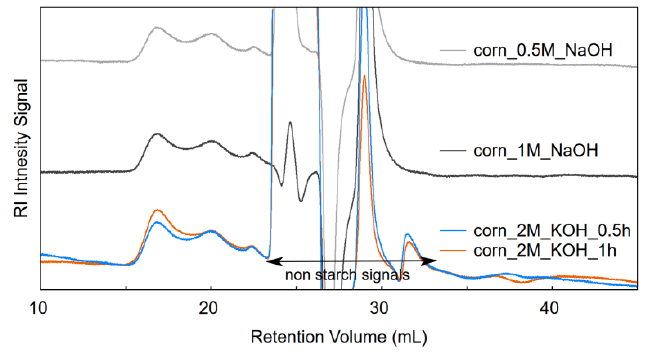
Figure 4. SEC chromatograms of corn starch samples dispersed in aqueous solution NaOH or KOH at 65 °C and eluted with 50 mM phosphate buffer (pH 8.0) with 100 mM